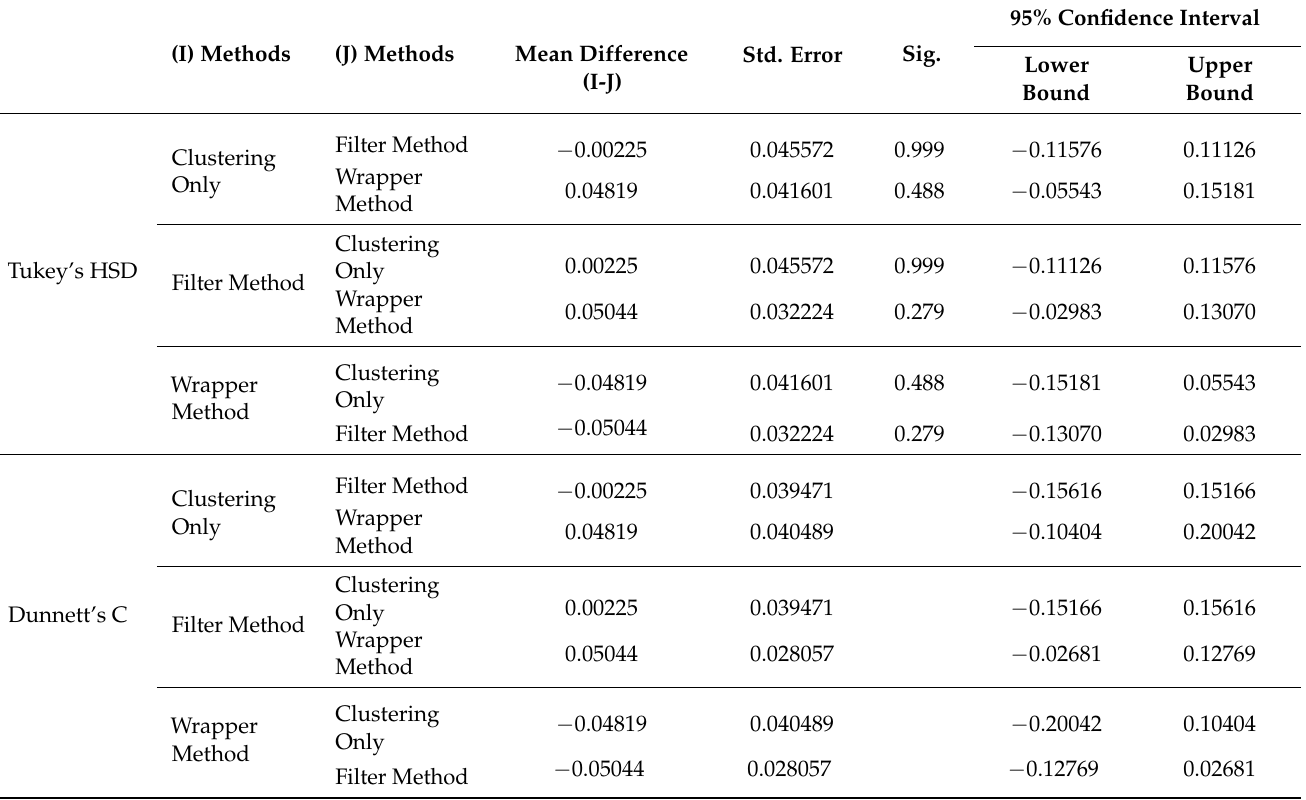
Table 3. Multiple comparisons.